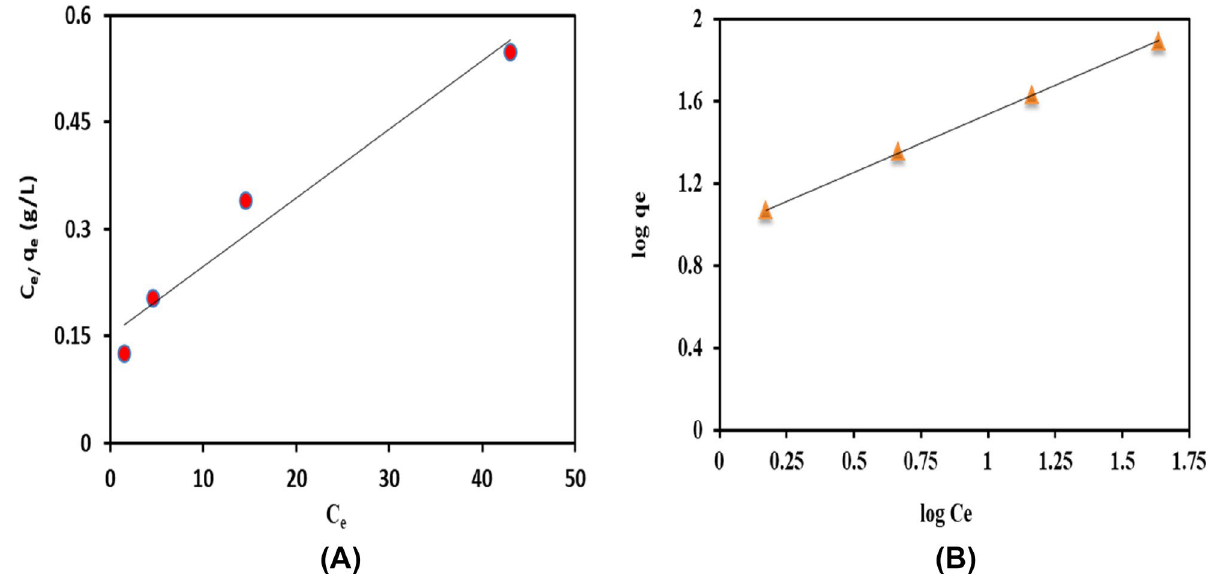
Figure 8. Adsorption isotherm plots of ( A ) Langmuir and ( B ) Freundlich